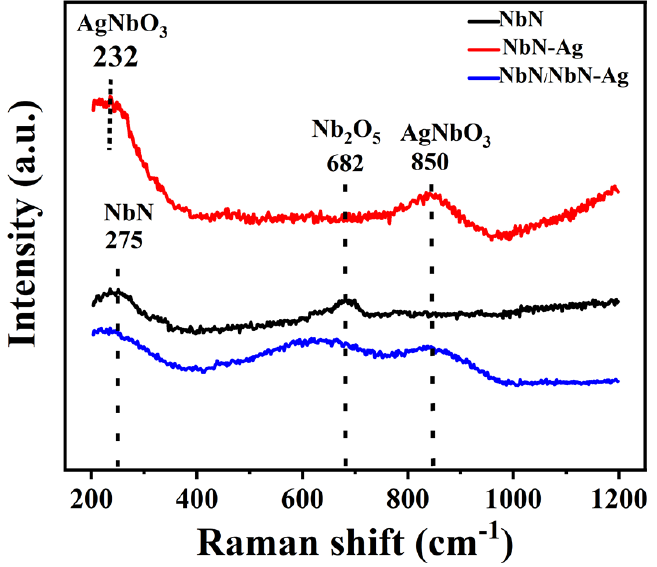
Figure 8. Raman spectra of the wear tracks of the NbN, NbN-Ag and multilayer films after friction test at RT.